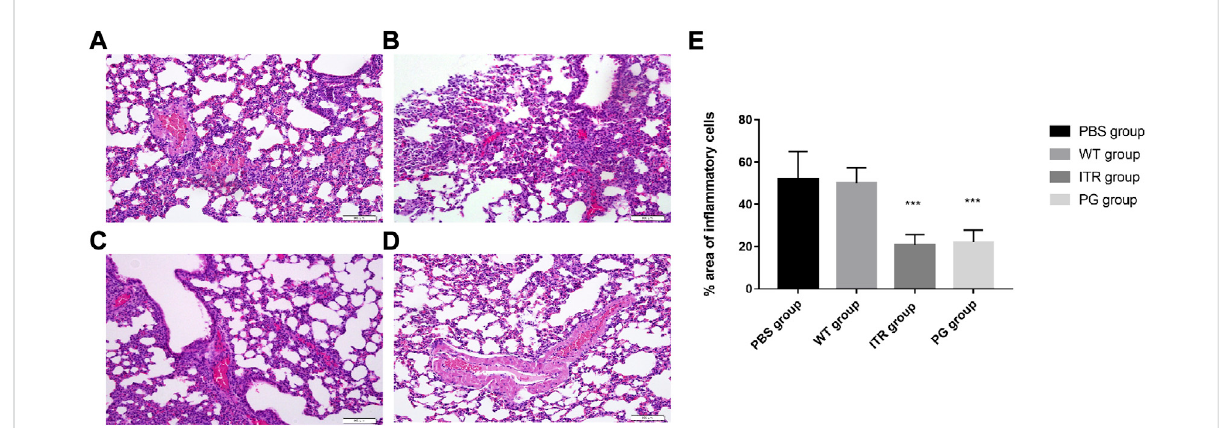
FIGURE 8 ImagesofH&E-stainedlungsof S.globosa -infectedmicetreatedwithvariousformulationsonday20;magni fi cation×200. (A) PBSinjection, (B) WT injection, (C) itraconazole injection, and (D) PG injection. (A,B) A higher number of in fl ammatory cells was observed. In contrast, (C,D) showed a dramatic decrease in neutrophil and lymphocyte in fi ltration. (E) Compared with the PBS group, the percentage area of in fl ammatory cells in the different treatment groups on day 20. Results are representative of three independent experiments. WT: wild-type phage injection; ITR: itraconazole injection; PG: phage-GK injection.